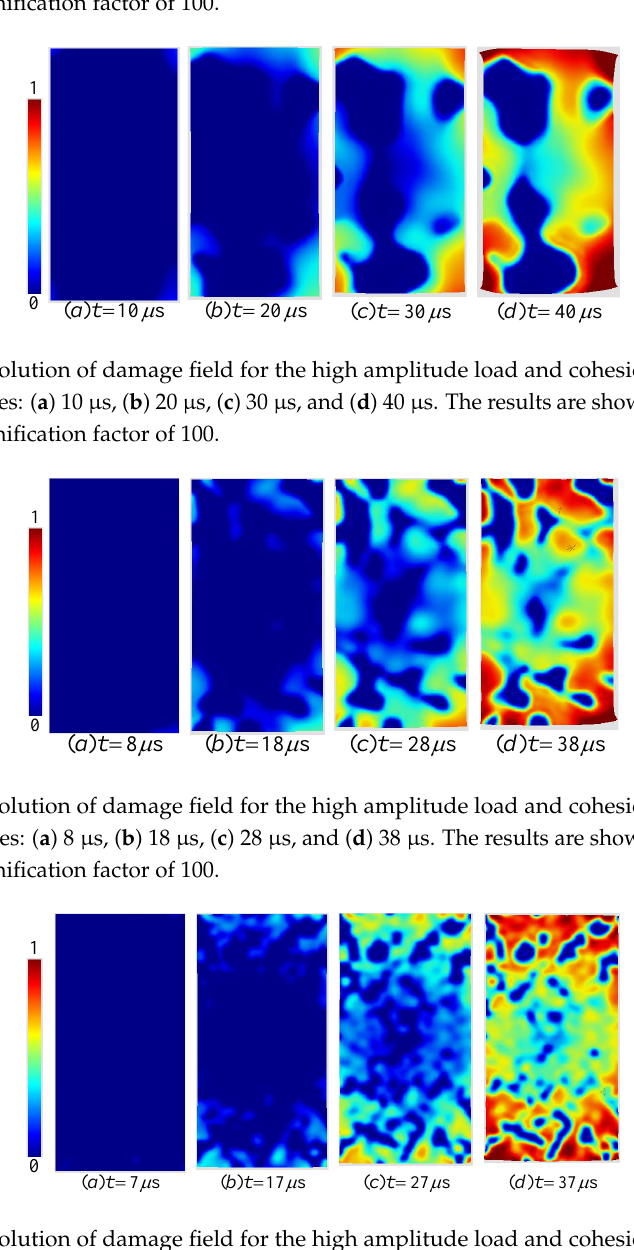
Figure 18. The evolution of damage field for the high amplitude load and cohesion realization with l c = 5 mm at times: ( a ) 7 µ s, ( b ) 17 µ s, ( c ) 27 µ s, and ( d ) 37 µ s. The results are shown on the deformed mesh with a magnification factor of